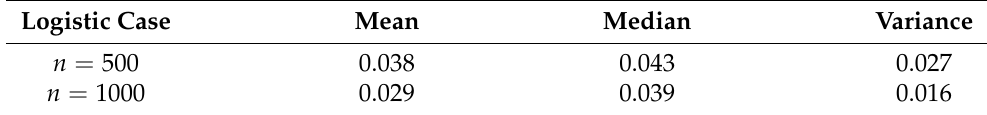
Table 12. The RASE criterion with the non-parametric function η ( . ) for both cases n = 500 and n =